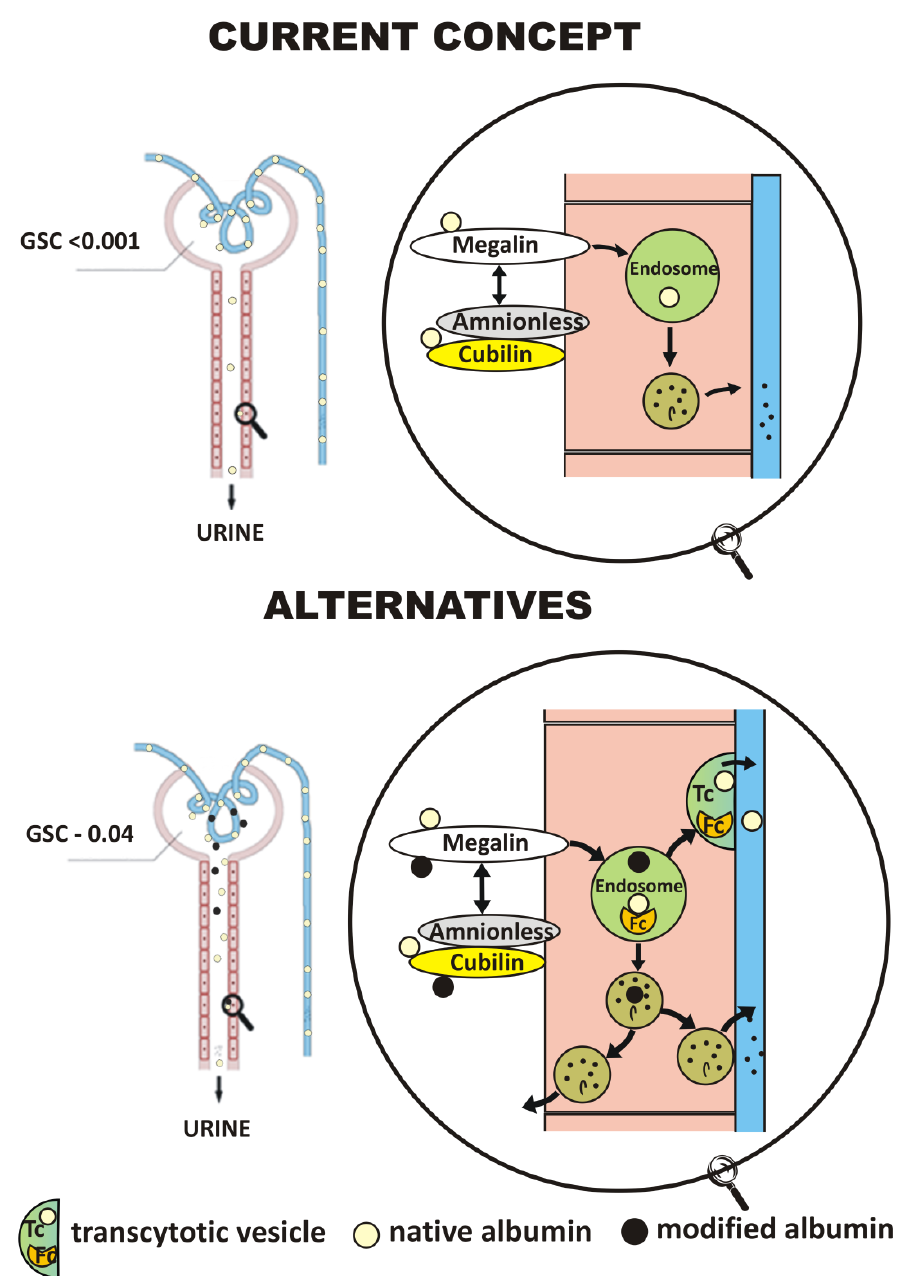
Figure 2. Renal catabolism of albumin—current concepts and alternatives. The generally accepted model assumes a relatively low level of glomerular albumin filtration due to its relatively large size and low isoelectric point, efficient reabsorption by endocytosis, involving megalin and cubilin-amnionless complex, vesicular transport to lysosomes and hydrolysis to single amino acid residues. In this model, only a negligible amount of albumin is excreted in urine, and the degradation products mostly return to circulation. The controversies concern both the quantitative and qualitative aspects of this process. New studies indicate, inter alia, that albumin permeation can occur with a GSC of 0.04. In the proposed model, native molecules undergo mainly transcytosis, while structurally modified molecules, i.e., oxidized or glycated, follow the classical path, with lysosomal degradation taking place to a limited extent. Most degradation products are short polypeptides that are secreted into the lumen of the tubule.